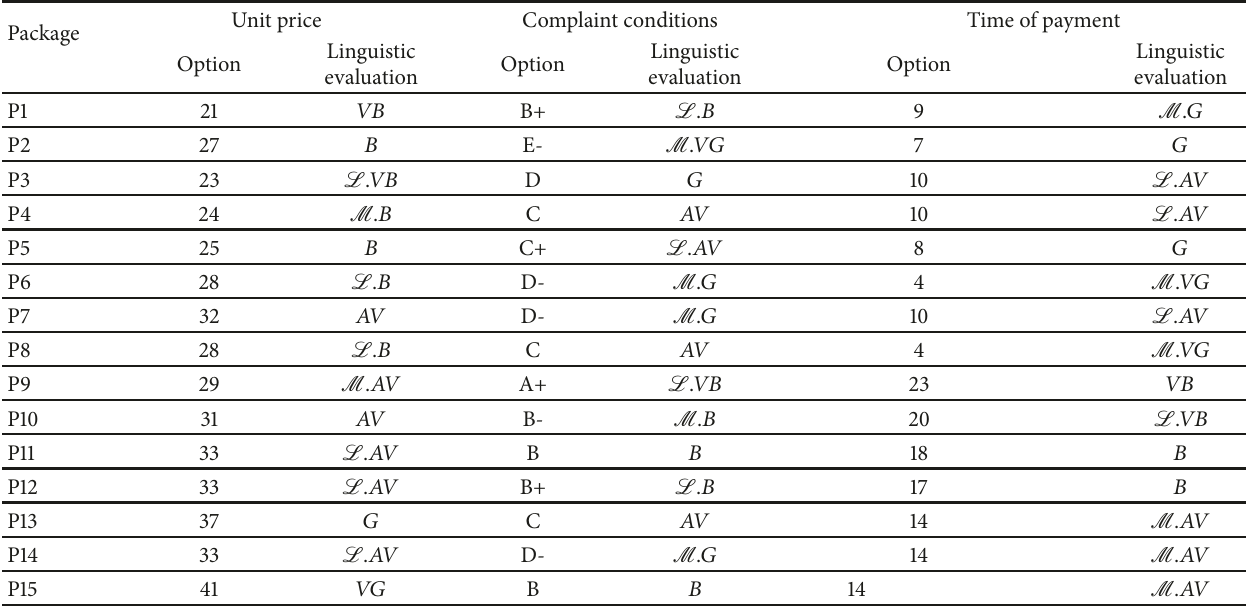
Table 3: Negotiations packages and their linguistic